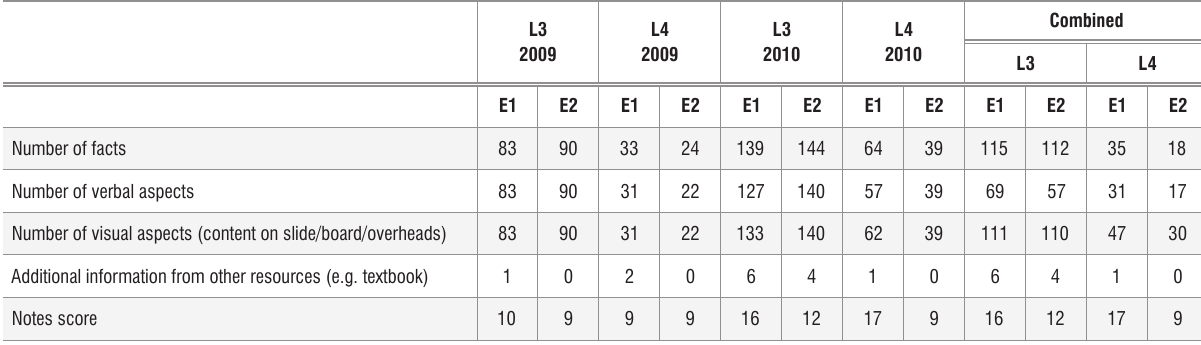
Comparison of Semester 2 note-making averages between first- and second-language